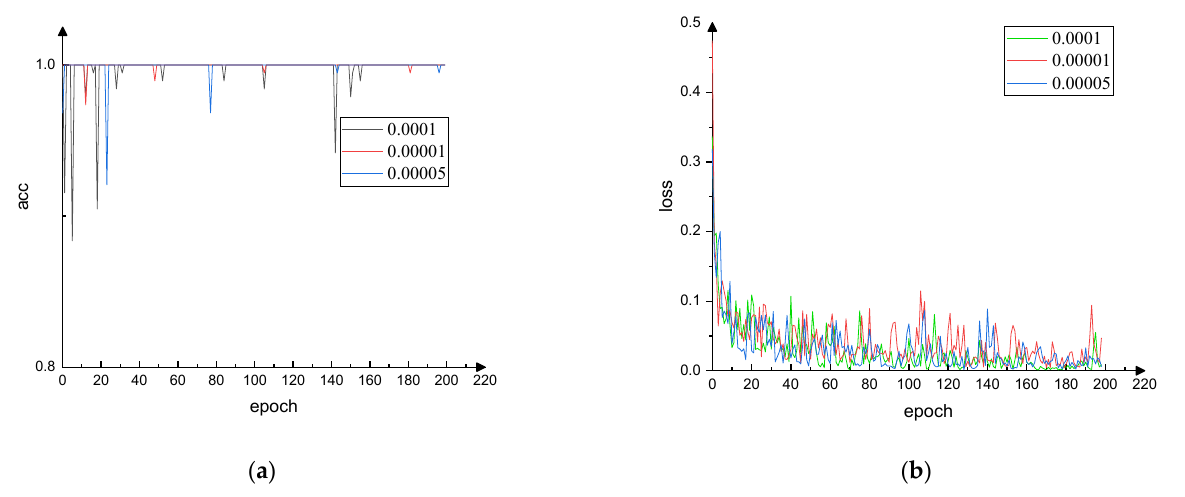
Figure 17. ( a ) Effect of different learning rates on test accuracy. ( b ) Effect of different learning rates on training loss. on training